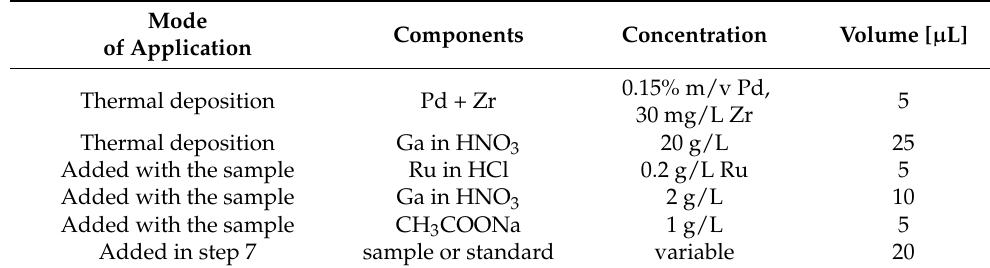
Table 2. Concentrations and volumes of the modifier solutions and the Ga reagent used for thermal pretreatment and injection together with the sample.